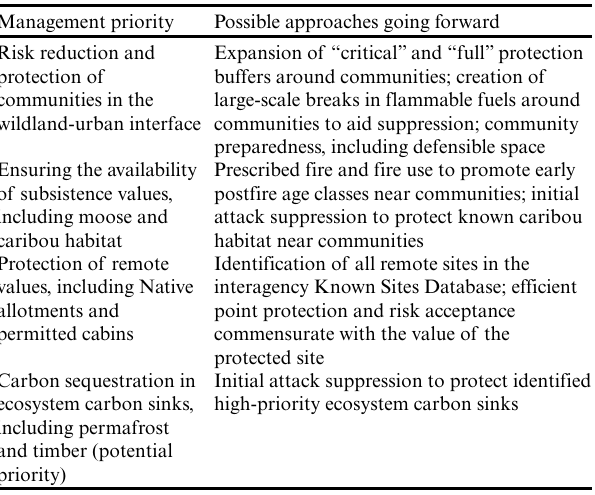
Table 2 . Current key priorities for Alaska fire management identified by